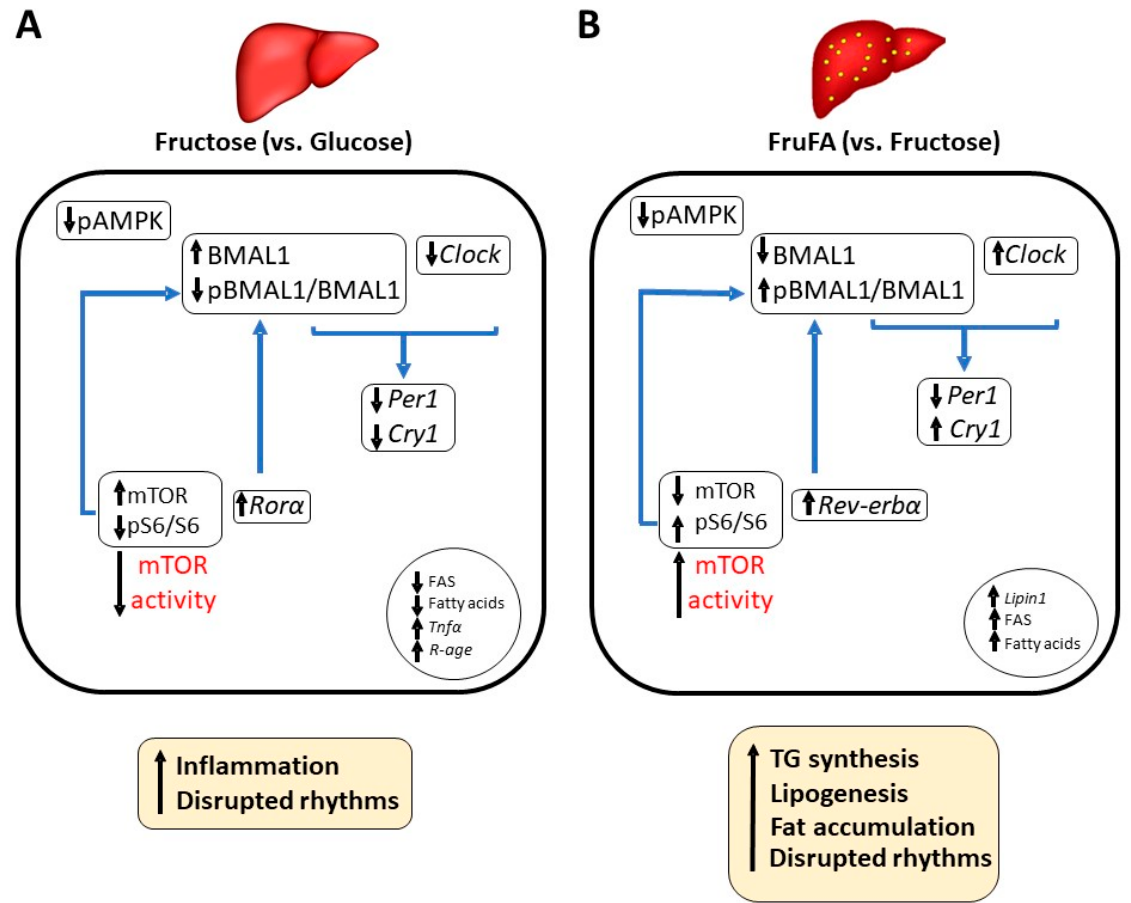
Figure 6. A proposed model delineating how fructose and fructose-induced steatosis modulate the circadian clock mechanism and metabolism in the liver. ( A ) High fructose consumption compared to high glucose consumption. ( B ) High fructose consumption in existing steatosis settings compared to non-steatosis settings.